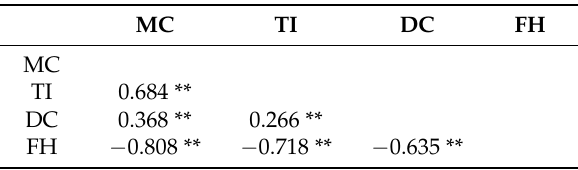
Table 2. Pearson’s correlation matrix regarding the parameters time-to-ignition (TI), duration of combustion (DC), flame height (FH) and fuel moisture content (MC).